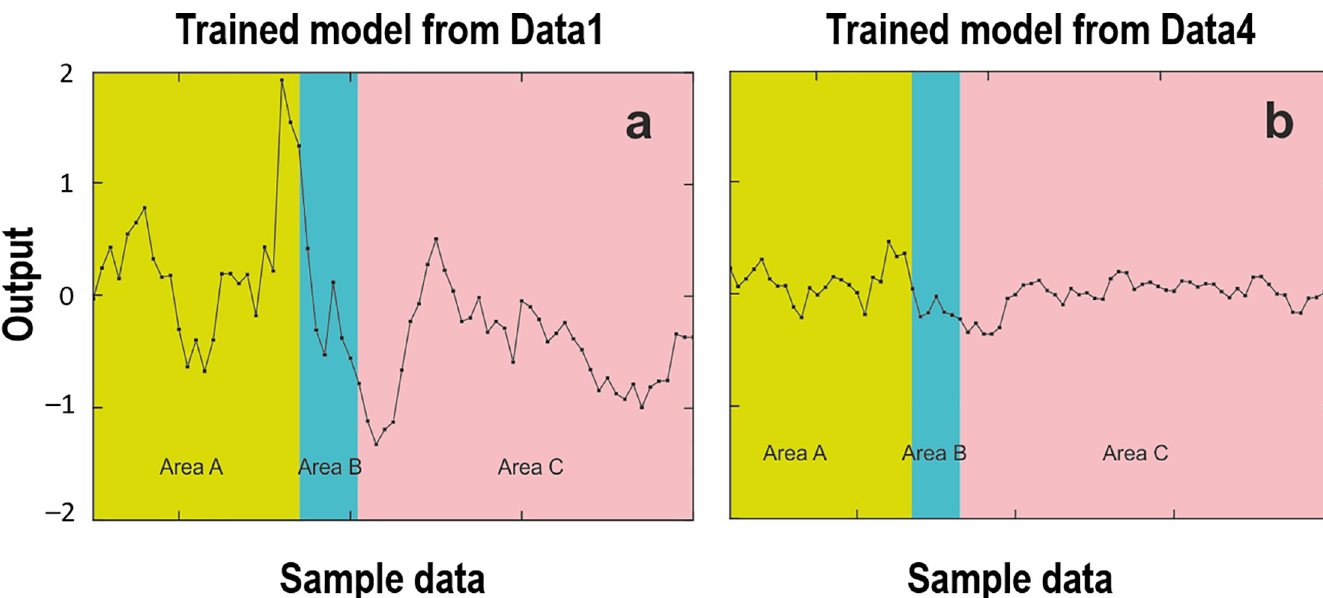
Fig 8. Weight specific growth rate (SGR) predictions (outputs) of wild Northeast Arctic cod at adult stage during spawning migration in three different Barents Sea areas (see Figs 3 and 4). A comparison was made using two trained weight-parameter sets for the models of SGR estimates in (a) Data1: Atlantic salmon at juvenile stage (Fig 1A), and (b) Data4: rainbow trout at adult stage (Fig 1D), to predict the SGR of wild Northeast Arctic cod at adult stage. To test the predictions, we used the normalized weight, normalized pyloric caecal activity ratio of trypsin to chymotrypsin (T/C ratio) and normalized condition factor (CF) of the wild Northeast Arctic cod at adult stage as the model inputs (see Figs 4 and 5). The models generate normalized SGR predictions for the wild Northeast Arctic cod at adult stage in area A (between North Kanin Bank and Eastern Basin), area B (Kanin Bank), and area C (Central Bank). trained model from Data1+Data2+Data3+Data4+Data5 were converted to the estimated real